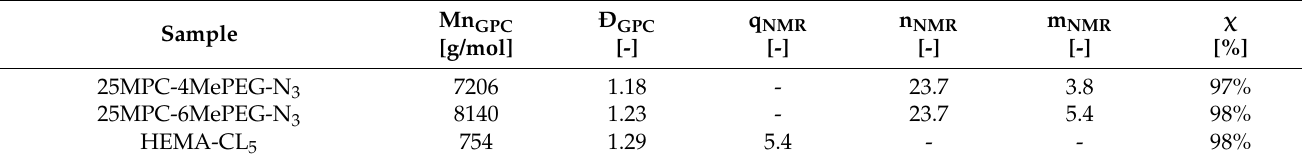
Figure 3. ( a ) 1 H NMR of N-(4-phenoxypyridin-3-yl)-N-(2-(prop-2-yn-1-yloxy)benzyl)acetamide (PBR28-alkyne) (6) recorded in CDCl 3 at 400 MHz. ( b ) Mass spectrum of the PBR28-alkyne confirming the correct synthesis of 6, with high purity. Characteristics of the hydrophilic macro RAFT agents and of the macromonomer obtained via ROP. Mn GPC = number-averaged molecular weight obtained from GPC, Ð GPC = polymer dispersity, q NMR = degree of polymer- ization of the hydrophobic macromonomer (i.e., average number of repeating CL units) derived from NMR, n NMR = degree of polymerization of MPC obtained from NMR, m NMR = degree of polymerization of MePEG-N 3 obtained from NMR, χ = monomer conversion from